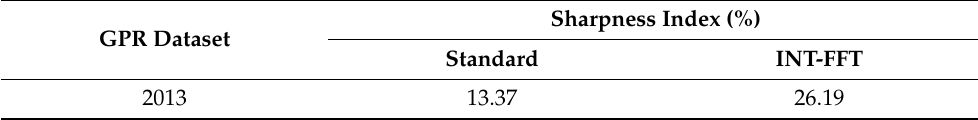
Figure 11. Differences between the cover surfaces of the 2013 GPR dataset: ( a ) standard processing; ( b ) after the INT-FFT algorithm. The data interpolation naturally amplifies the presence of background reflections that we consider noise originating from the collapse of structures and soil heterogeneities. Table 5. Sharpness index of the cover surfaces from 2013 GPR datasets before and after INT-FFT processing. The sharpness increases with additional applied processing.